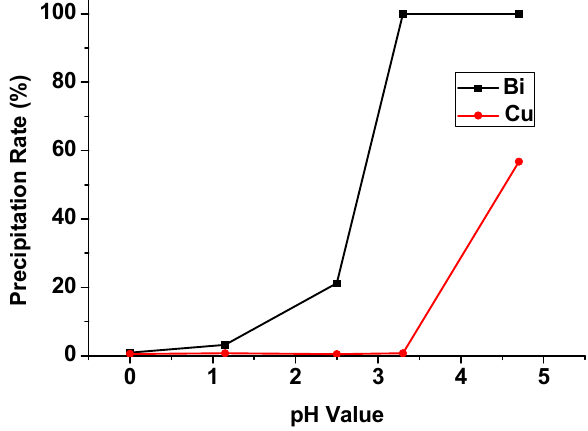
Figure 13. Precipitation percentage of Bi and Cu at different pH values.